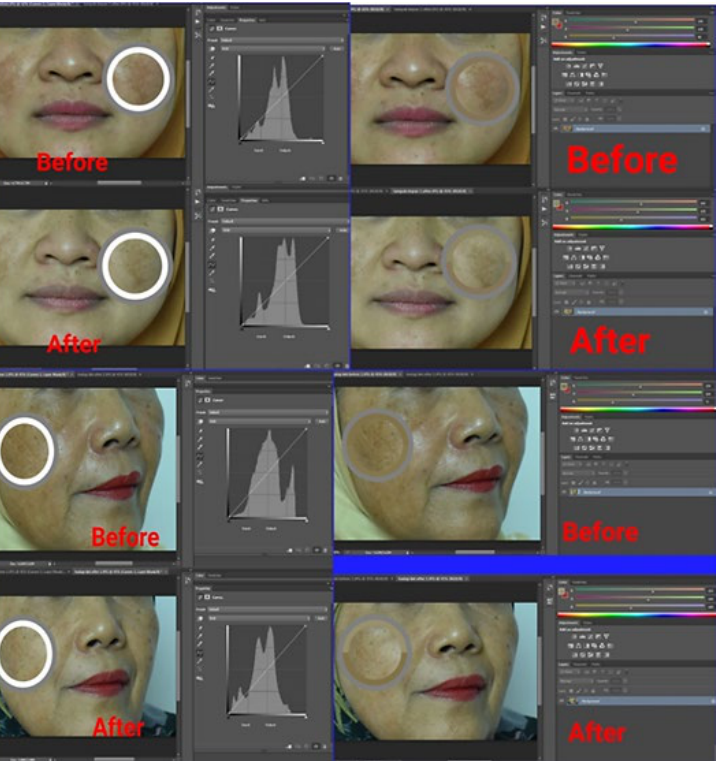
Figure 7. Image analysis using RGB score 1 and Photoshop to evaluate spot intensity before and after use of the α -mangostin-loaded USUC.